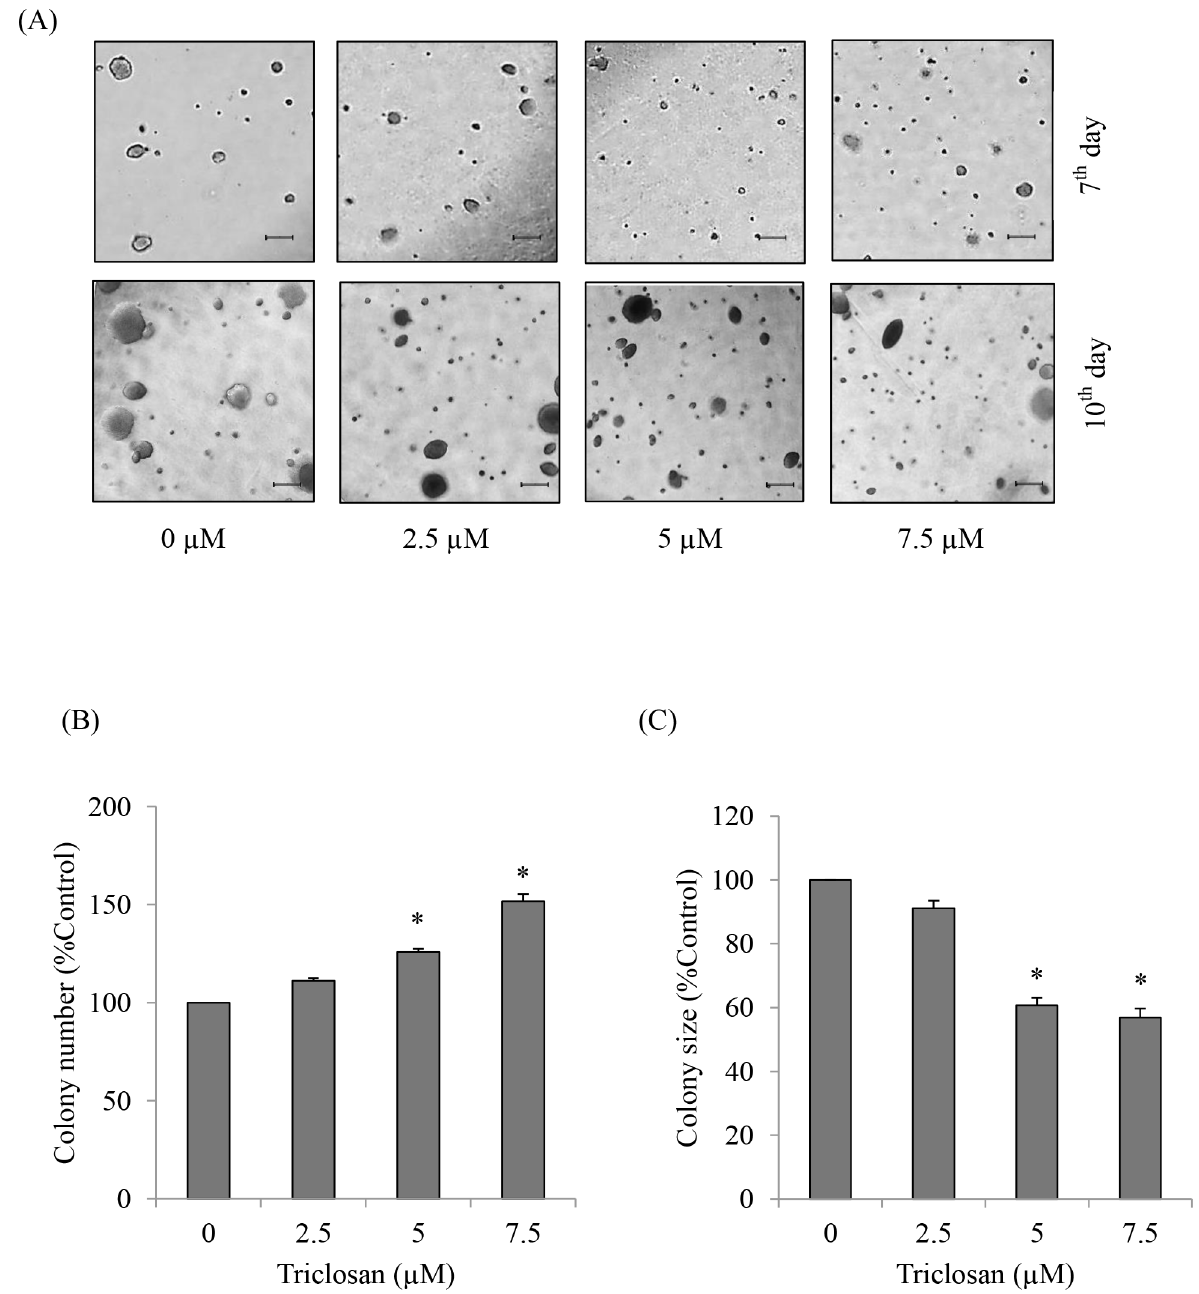
Figure 2. Effects of TCS on anchorage-independent growth of anoikis resistant H460 cells. (A) Cells were pretreated with TCS (0–7.5 m M) for 24 h and subjected to soft agar colony formation assay, as described in ‘‘Materials and Methods’’. Representative fields from three independent experiments were photographed after the cells were cultured for 7 and 10 days. Scale bar is 1,000 m m. (B–C) Colony number and colony size were determined by image analyzer on the 10 th day of culture. Values are means of the three independent triplicate samples 6 SE. * P , 0.05 versus non- treated control.